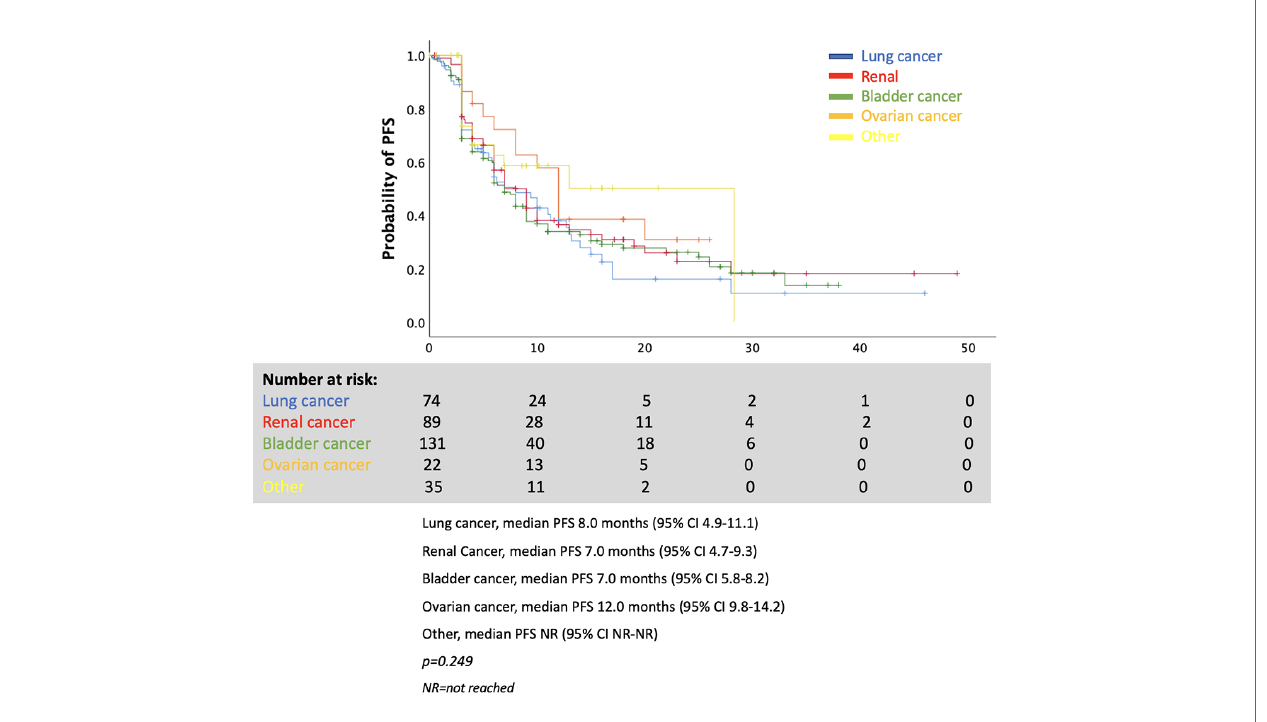
FIGURE 3 | Progression-free survival by cancer